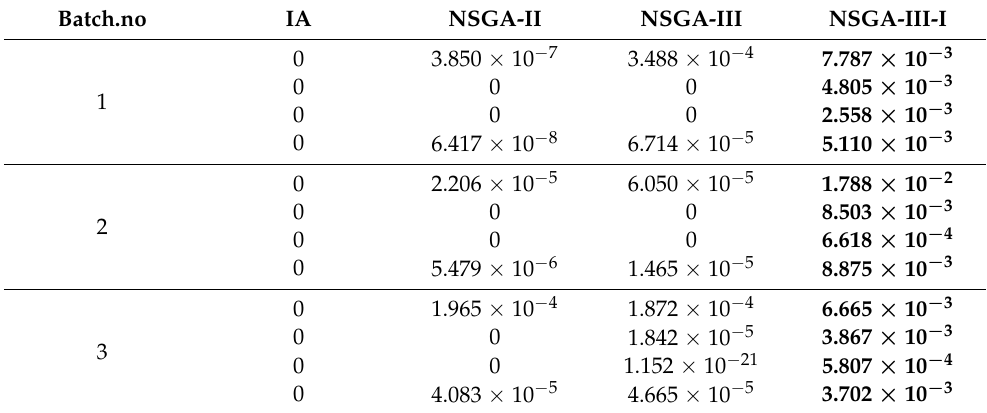
Table A5. Performance comparison between the proposed algorithm and other algorithms on the experimental problem with a batch size of 100.